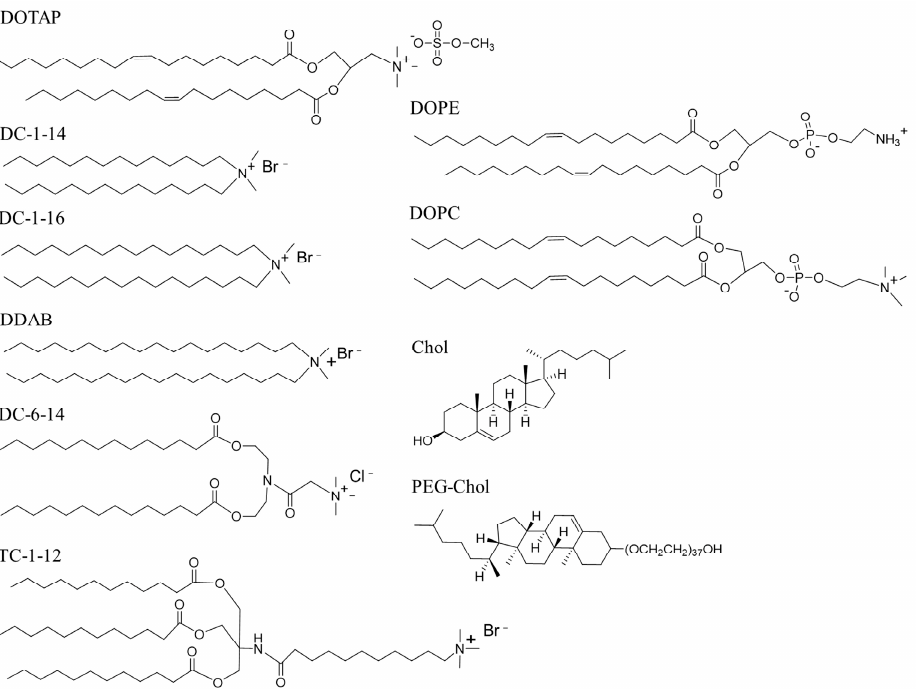
Figure 1. Structure of cationic lipids, neutral helper lipids, and the PEG-lipid used in this study. DOTAP: 1,2-dioleoyl-3-trimethylammonium-propane methyl sulfate salt; DC-1-14: N , N -dimethyl- N -tetradecyltetradecan-1-aminium bromide; DC-1-16: N -hexadecyl- N , N -dimethylhexadecan-1-aminium bromide; DDAB: N , N -dimethyl- N -octadecyloctadecan-1-aminium bromide; DC-6-14: 2-(bis(2-(tetradecanoyloxy)ethyl)amino)- N , N , N -trimethyl-2-oxoethan-1-aminium chloride; TC-1-12: 11-((1,3-bis(dodecanoyloxy)-2-((dodecanoyloxy)methyl)propan-2-yl)amino)- N , N , N -trimethyl-11-oxoundecan-1-aminium bromide; DOPE: 1,2-dioleoyl- sn -glycero-3-phosphoethanolamine; DOPC: 1,2-dioleoyl- sn -glycero-3-phosphocholine; Chol: cholesterol; PEG-Chol: polyethylene glycol-cholesteryl ether. Table 2. Size of mRNA lipoplexes for in vitro transfection.